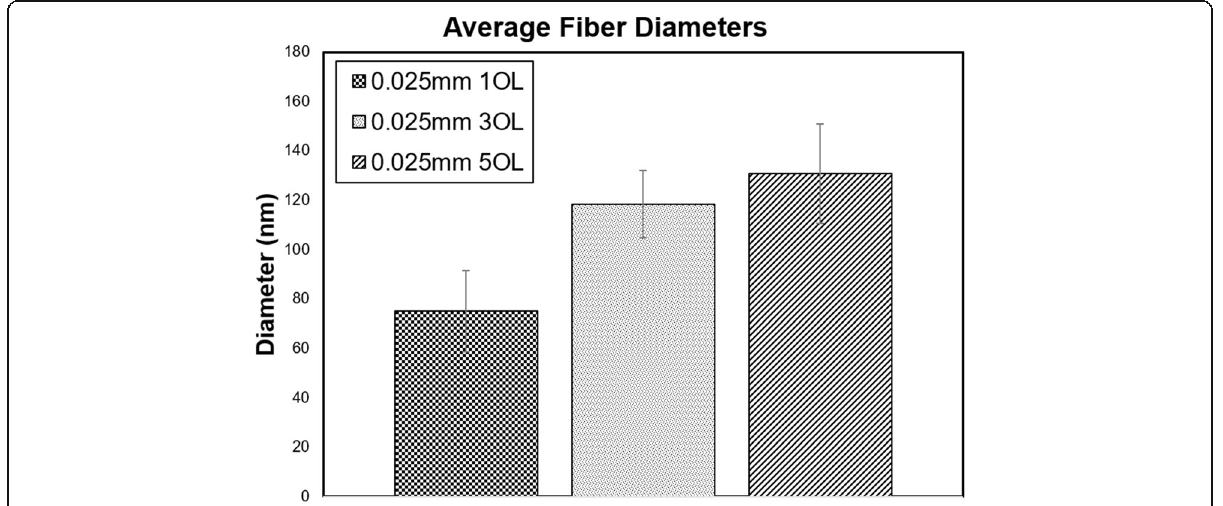
Fig. 9 Average fiber diameters calculated from SEM images at one, three, and five overlaps (OL)